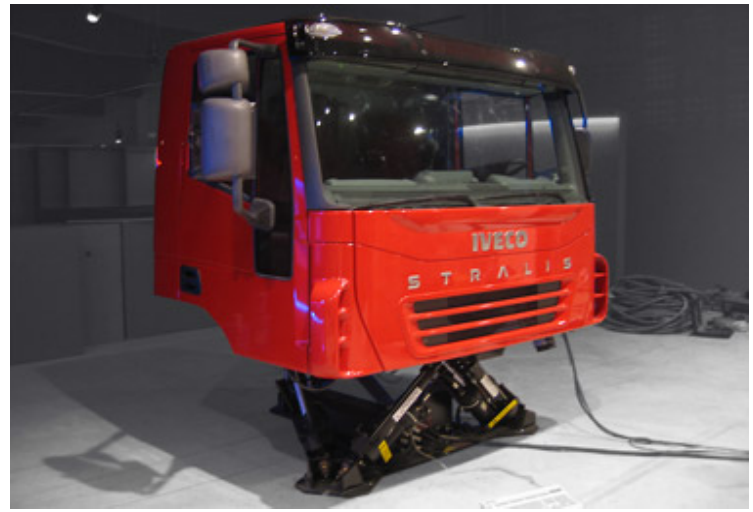
Figure 2. Truck simulator used in the experiments.